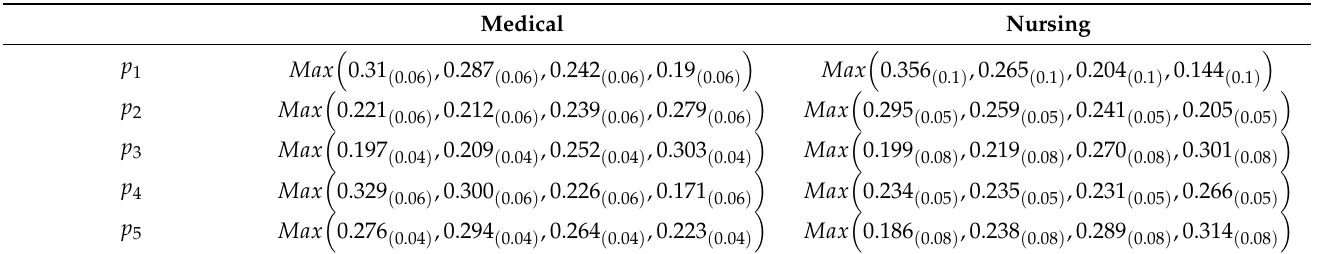
Table 4. The weighted decision-making coefficient vectors.